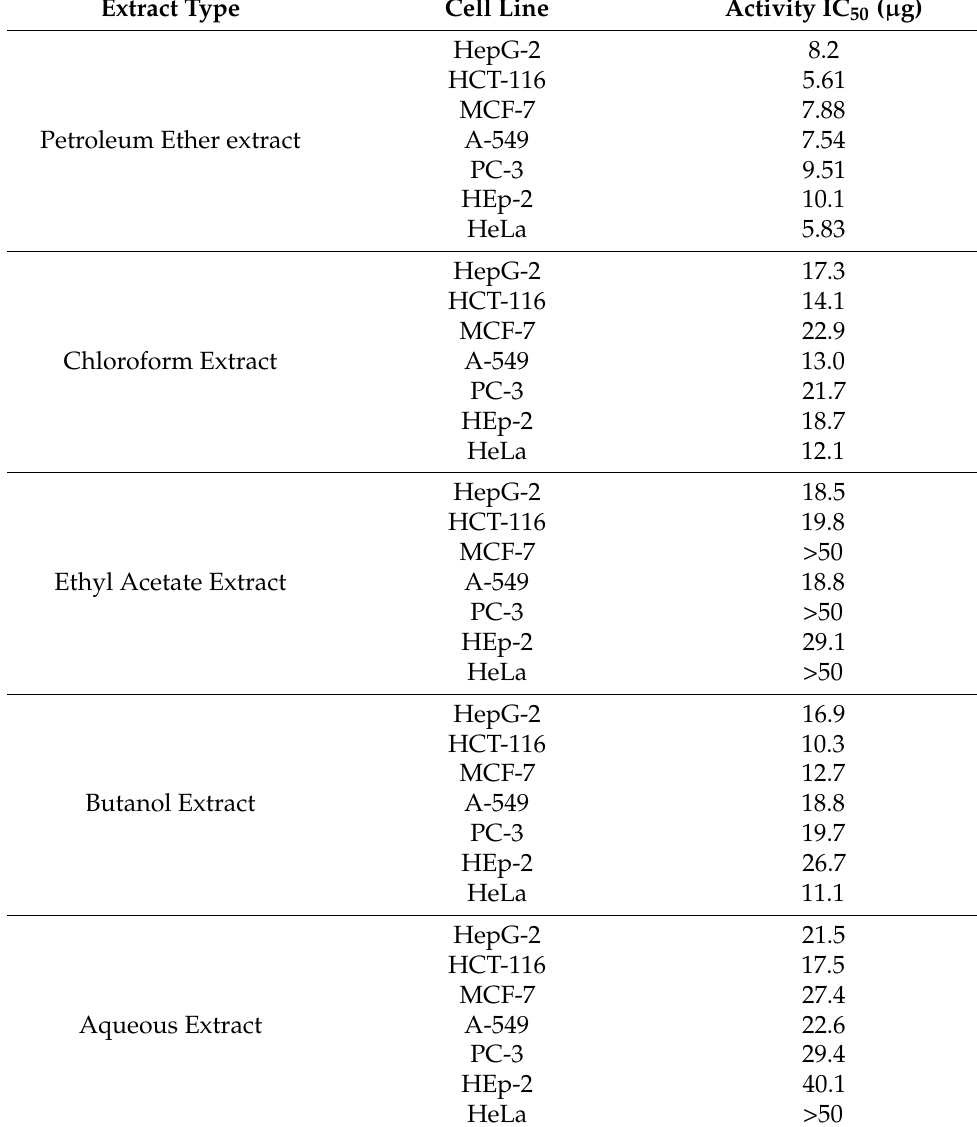
Table 1. The reported cytotoxic activities of Aloe perryi